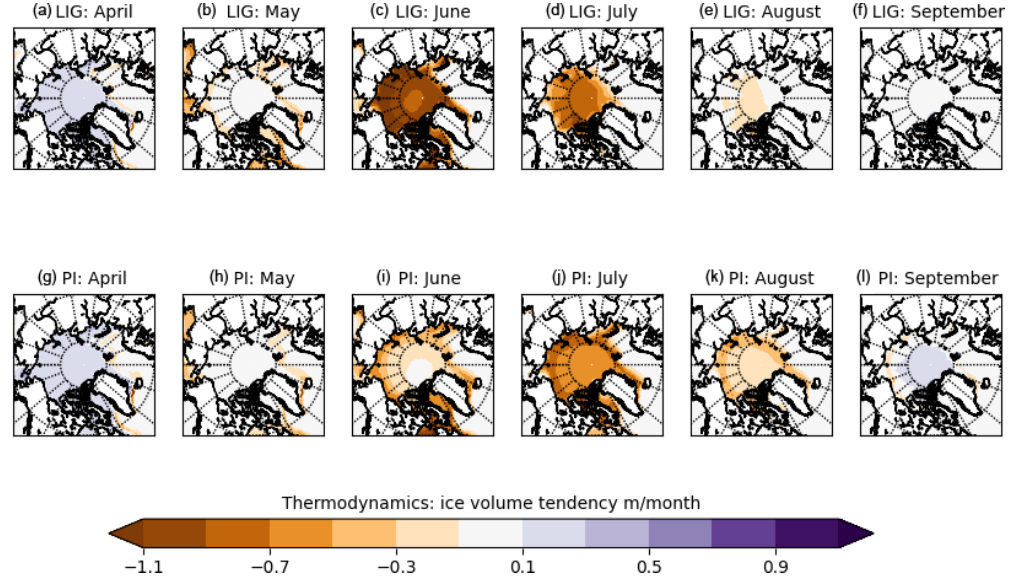
Figure 6. Maps of mean simulated ice volume tendency (metres per month) due to thermodynamics for the LIG and PI. The 200-year mean over the Northern Hemisphere for each month from April–September is shown, computed as the time average from monthly model output.